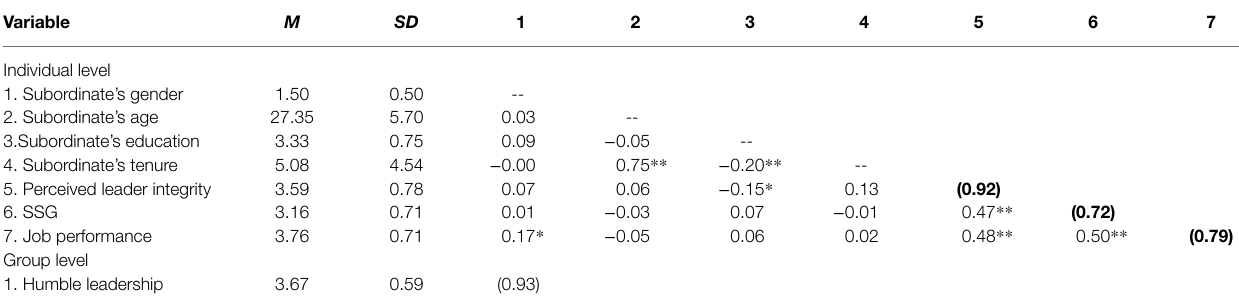
TABLE 2 | Means, standard deviations, and correlations between variables. Variable